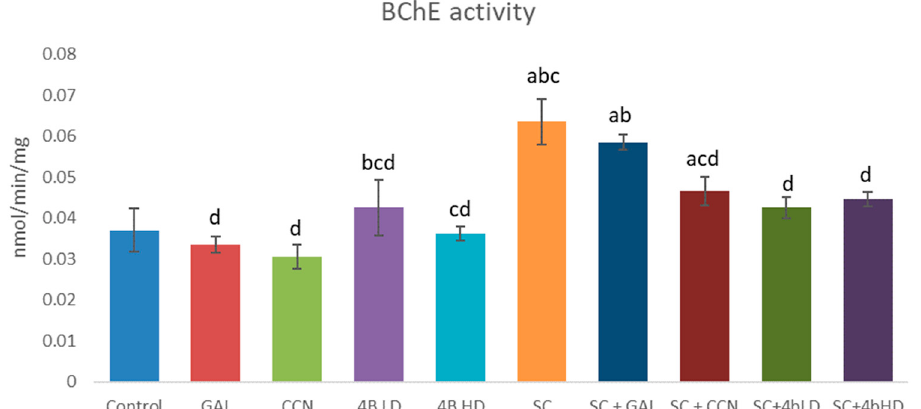
Figure 3. BChE activity measured for 10 min in brain homogenates from mice treated 14 days with GAL, CCN and 4b (two doses) alone and in combination with SC. a p < 0.05 vs. control; b p < 0.05 vs. GAL; c p < 0.05 vs. CCN; d p < 0.05 vs. SC.